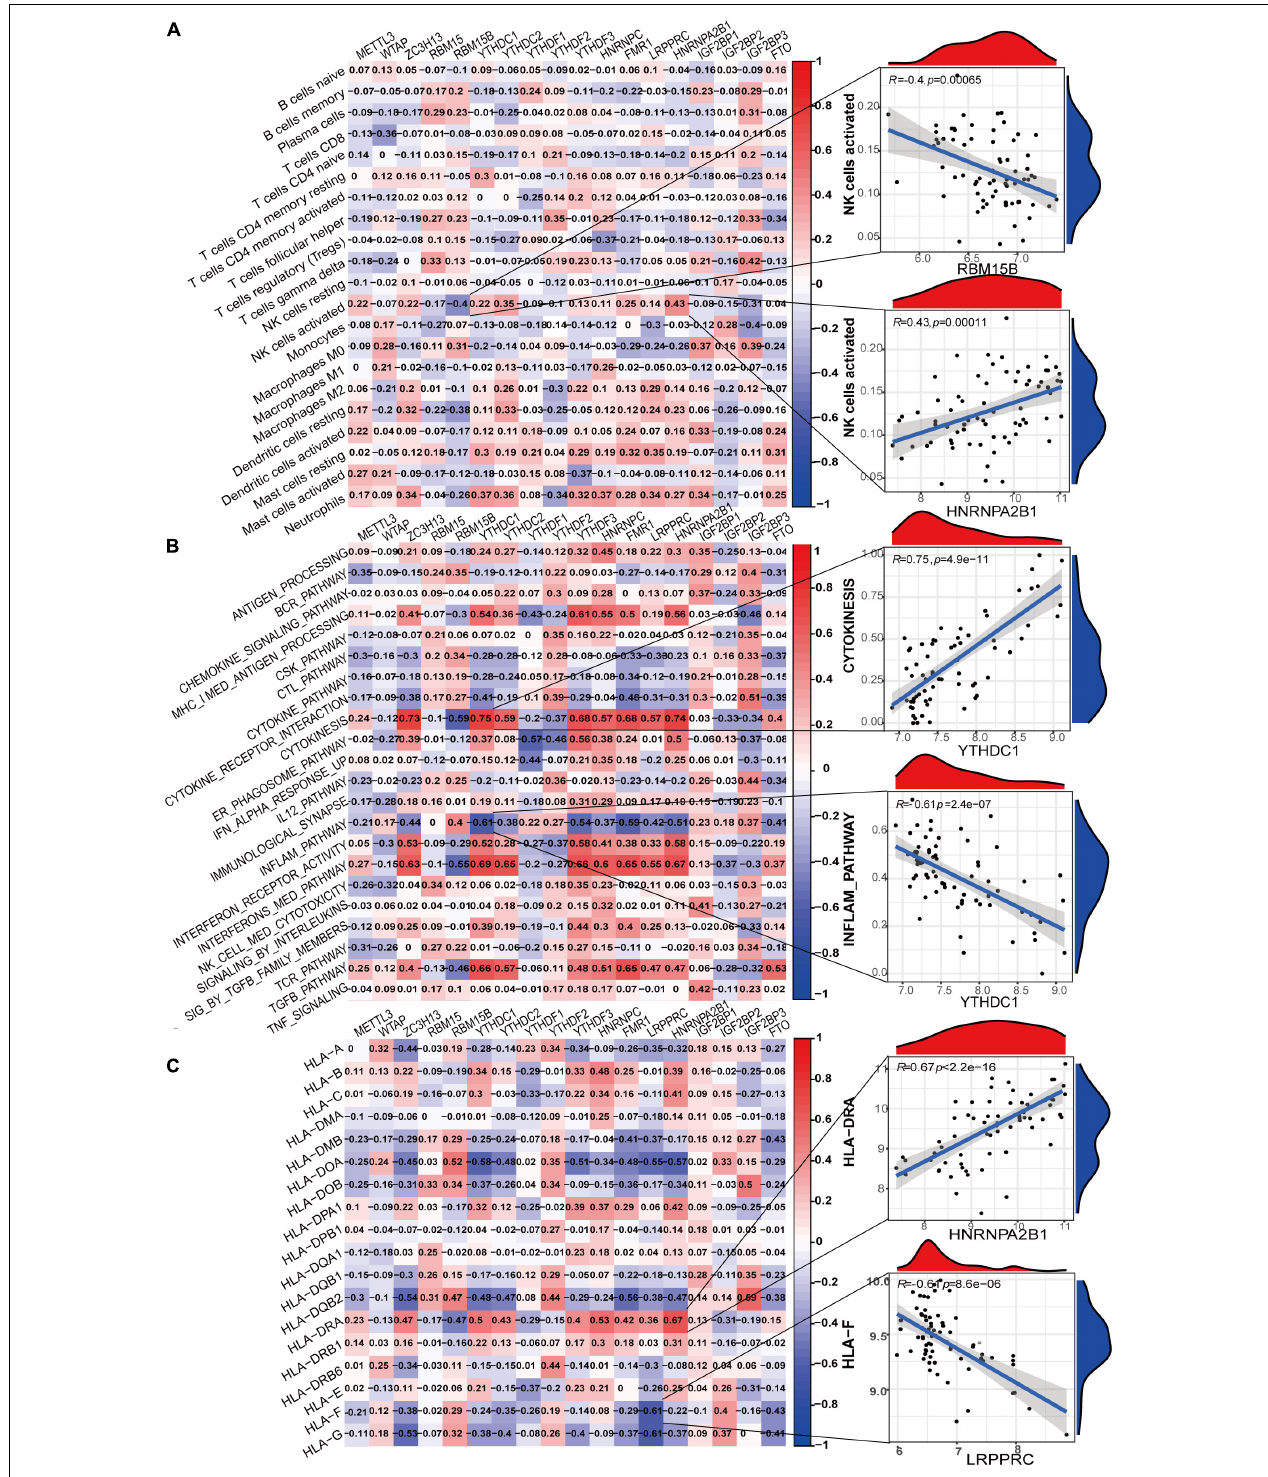
FIGURE 4 | Correlation between m 6 A regulator expression and immune characteristics in LN. (A) Heatmap of the correlations between 18 m 6 A regulators and 21 immunocytes (eosinophils with no expression were removed in all samples). The two respective scatterplots show the m 6 A regulator and immunocyte with the highest positive or negative correlation. (B) Heatmap of the correlations between 18 m 6 A regulators and immune response gene sets. The two respective scatterplots show m 6 A regulators and immune response gene sets with the highest positive or negative correlation. (C) Heatmap of the correlations between 18 m 6 A regulators and 18 HLA genes. The two respective scatterplots show m 6 A regulators and HLA genes with the highest positive or negative correlation.